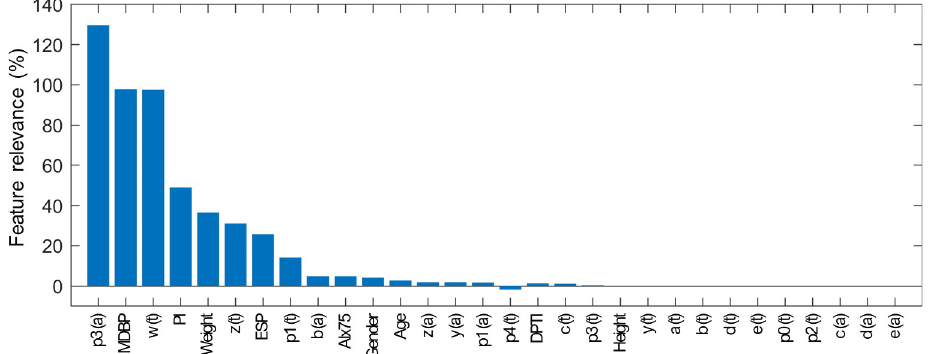
Fig 4. Feature relevance scores for SBP estimation model without a calibration measure. PWA-derived feature from the PPG waveform, as well as time (t) and amplitude (a) of characteristic points of its derivatives (VPG, APG and JPG) were of high relevance. Personal information had more weight than for the model with a calibration